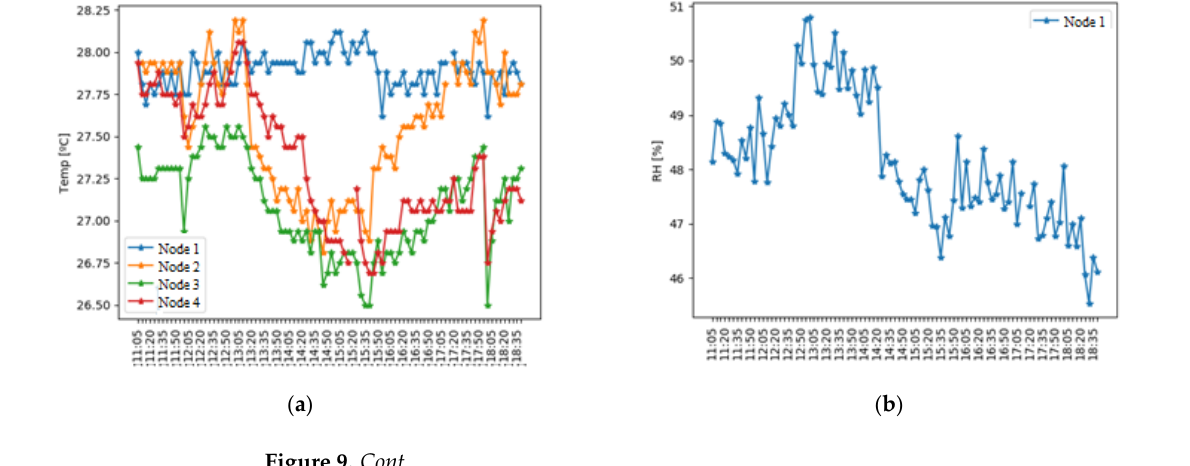
( d ) Figure 9. ( a ) Temperature measurements (LM74 sensors); ( b ) Relative humidity measurements (SHT85); ( c ) eCO 2 measurements (CCS811); ( d ) TVOC measurements (CCS811). 4.2. In a Laboratory during Several Laboratory Classes This test was carried out in a laboratory in May 2021. This laboratory is used for teaching purposes. The laboratory was occupied with three consecutive laboratory ses- sions of two hours, from 9:00 to 11:00; from 11:00 to 13:00; and from 13:00 to 15:00. The windows were always open. This test was aimed at measuring temperature and humidity parameters in the laboratory for evaluating the thermal comfort of the students. Five smart IEQ sensor nodes were located at different places. All five IEQ nodes ac- quired temperature (TMP37) but only one of them could also measure relative humidity (SHT85). Node 4 (red in Figure 10a) was next to the window, whereas the others were distributed along the laboratory. The obtained results show that the temperature conditions in the laboratory changed considerably, depending on where the nodes were located. In the morning, at 9:00, the overall temperature was between 25 and 28 degrees, but it reached 16 degrees next to the window. Also, it can be appreciated that Node 4 (red in Figure 10a) provides the closest value to the external temperature, which increased during the day.